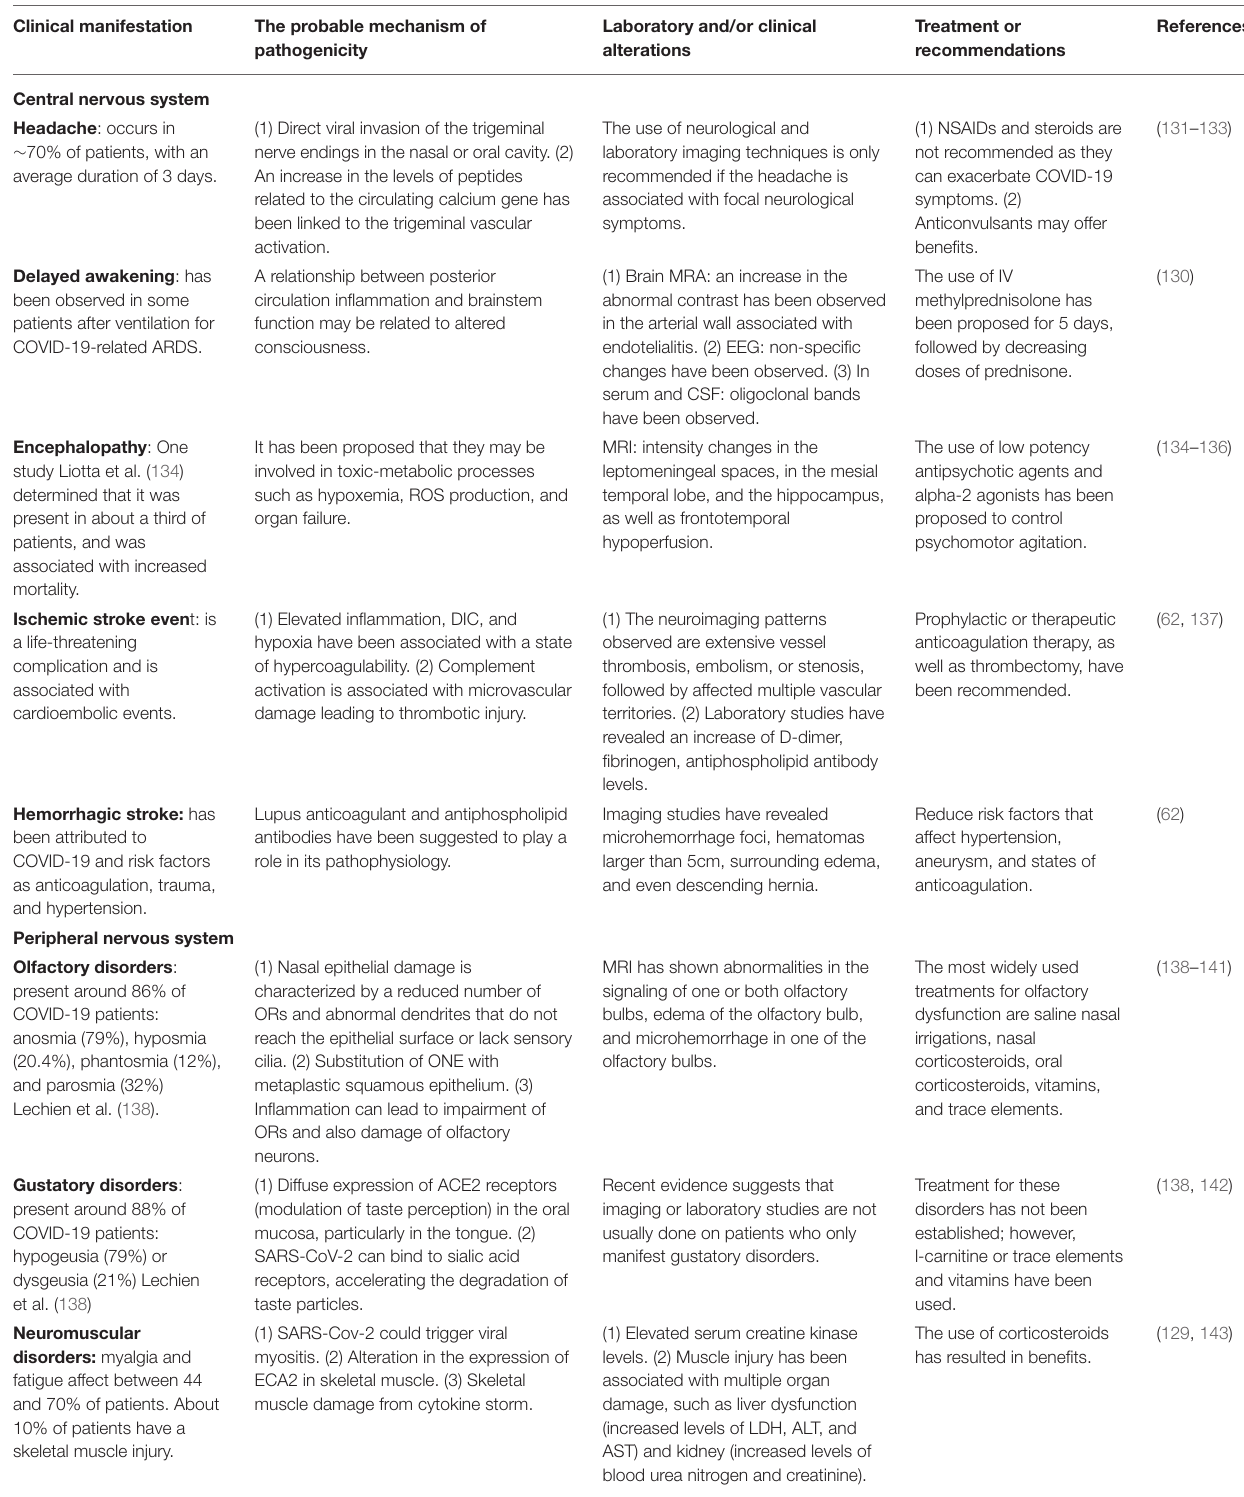
TABLE 2 | SARS-CoV-2 infection in the central and peripheral nervous system: clinical manifestations, mechanism of pathogenicity, laboratory, and clinical findings and suggested treatment. Clinical